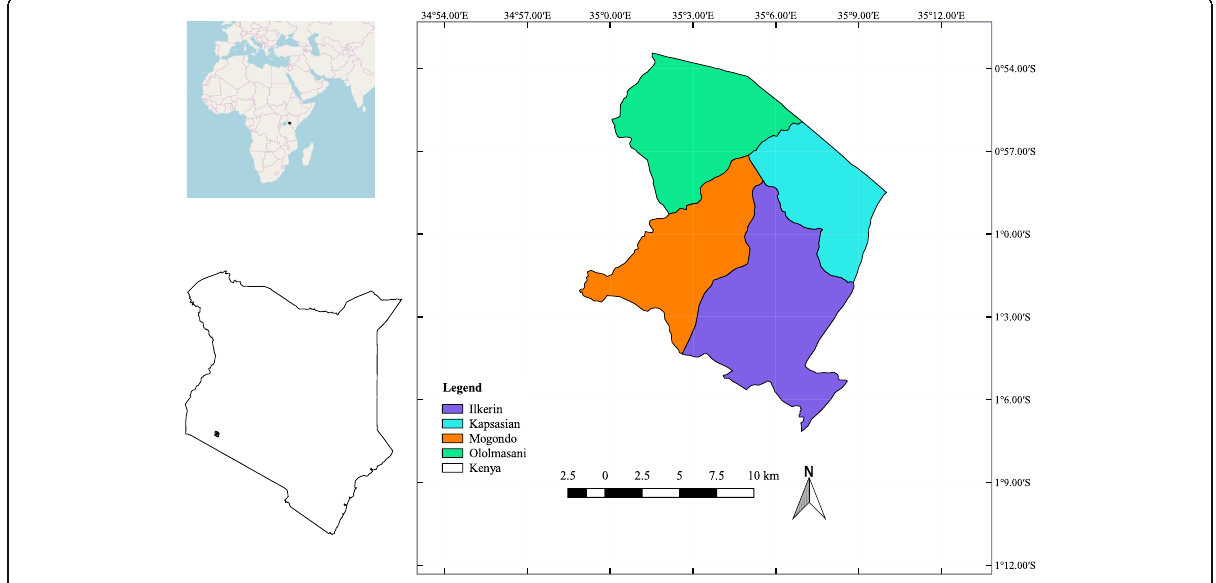
Fig. 1 A map showing location of the study area in Kenya (Source: Adapted from Survey of Kenya,